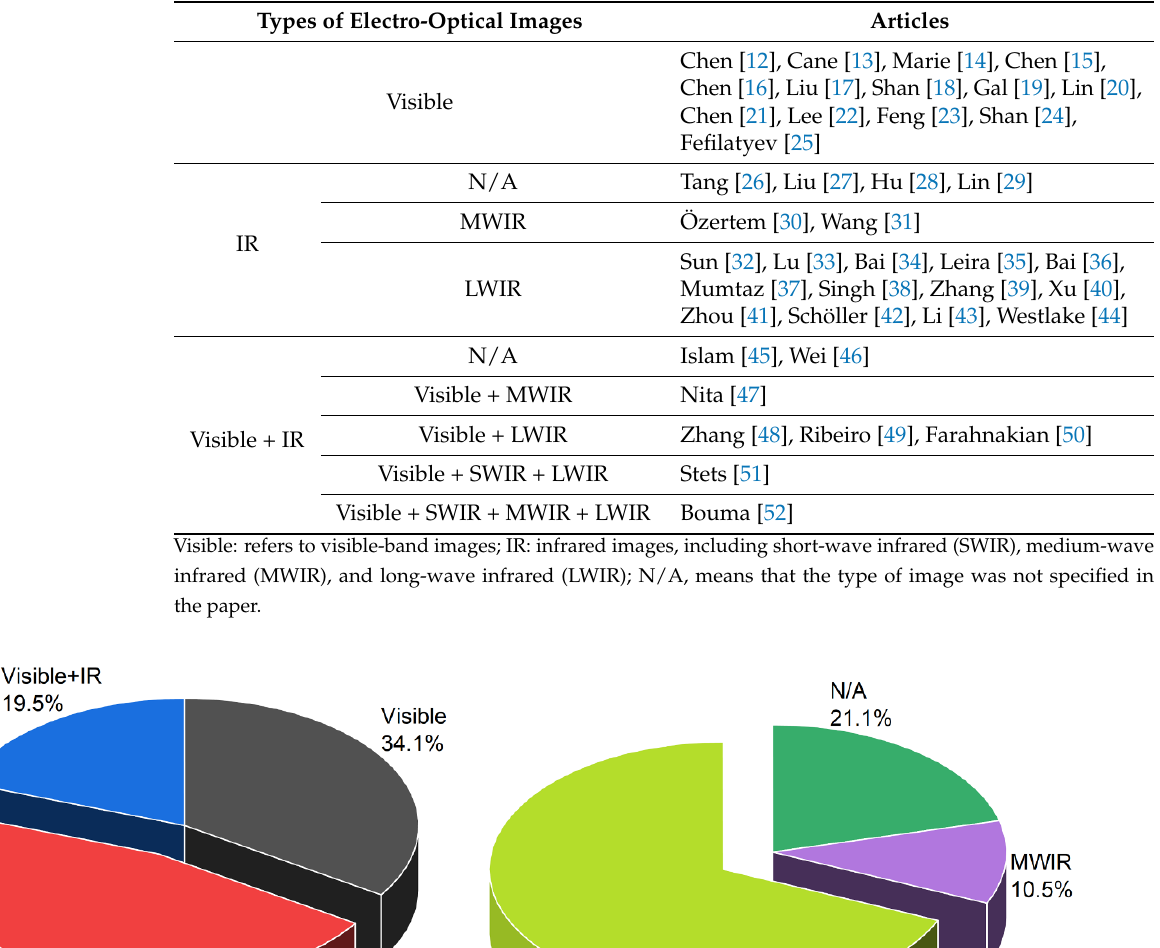
Table 1. Types of electro-optical images commonly used in ship detection.